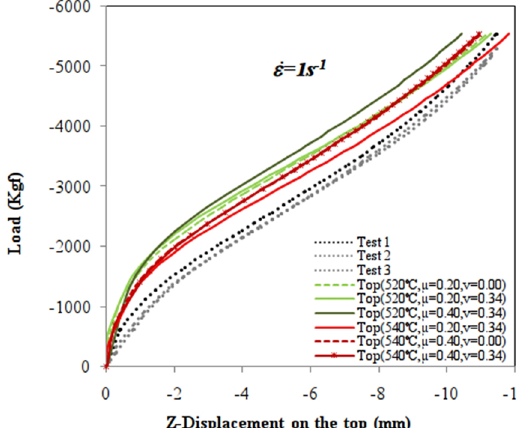
Figure 12. True Stress vs. True Strain curves measured experimentally (dotted lines), and Von Mises Stress vs. Von Mises Equivalent Strain curves in the middle of the sample calculated from simulations (solid lines), all of them tests at 540 °C and strain rate of 0.1 s -1 . Figure 13 are the True Stress measured experimentally and the Von Mises Stress calculated numerically on the bottom of the sample. The experimental stress also was calculated taking into account the friction corrections. 19,20